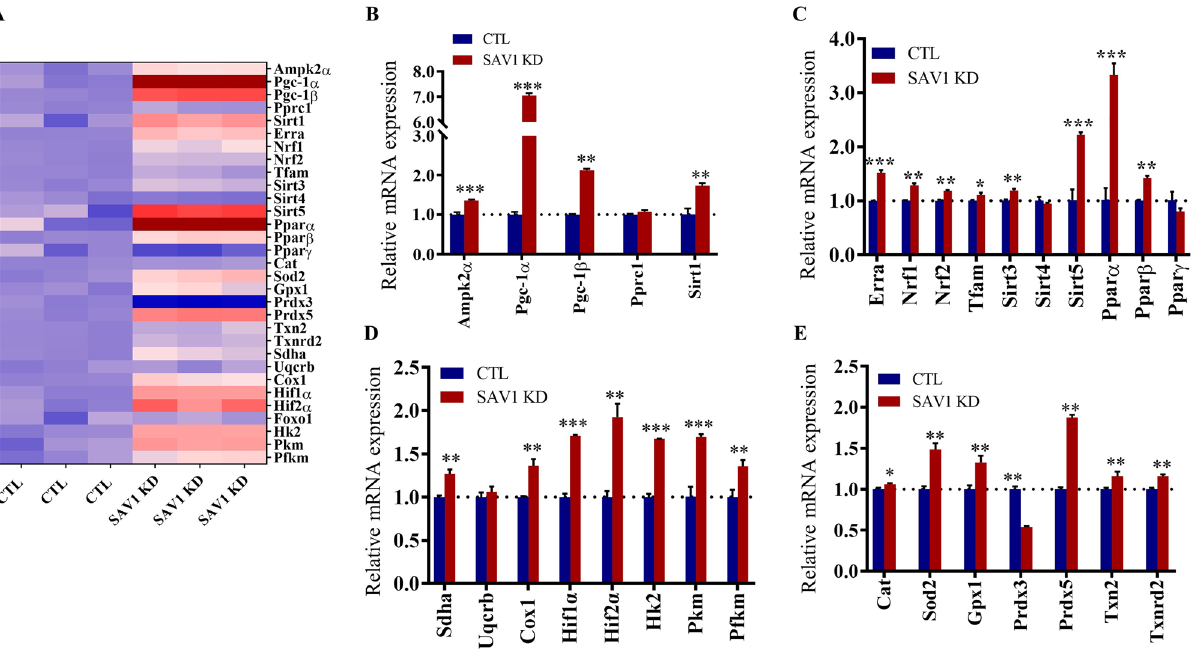
Figure 4. Quantitative analysis of gene expression profiles of SAV1 KD myoblasts. ( A ) Heat map visualization of real-time quantitative RT-PCR results showing the relative mRNA levels in SAV1 KD and CTL cells. The red color indicates high levels and the blue color indicates low levels of expression. ( B – E ) SAV1 KD significantly enhanced the transcription of genes regulating mitochondrial biogenesis, glycolysis, redox signaling, and the anti-oxidative response. Full gene names are described in the Results section. mRNA expression was normalized to 18 s rRNA. Unpaired t test; data are mean ± SD, n = 3 independent assays. ***p < 0.001, **p < 0.01, *p <